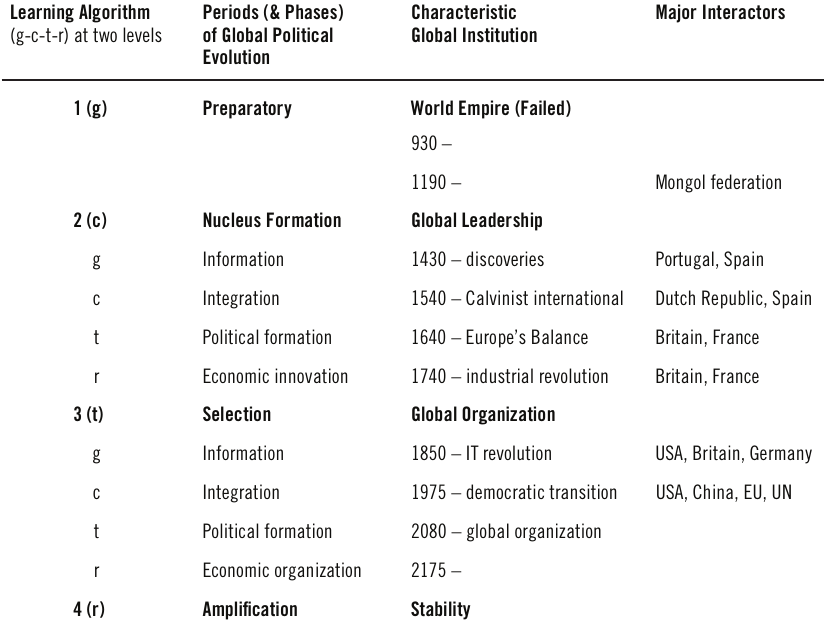
Table 1 – A Calendar of Global Politics: 1000 to 3000* Learning Algorithm Periods (& Phases) of Global (g-c-t-r) at two levels